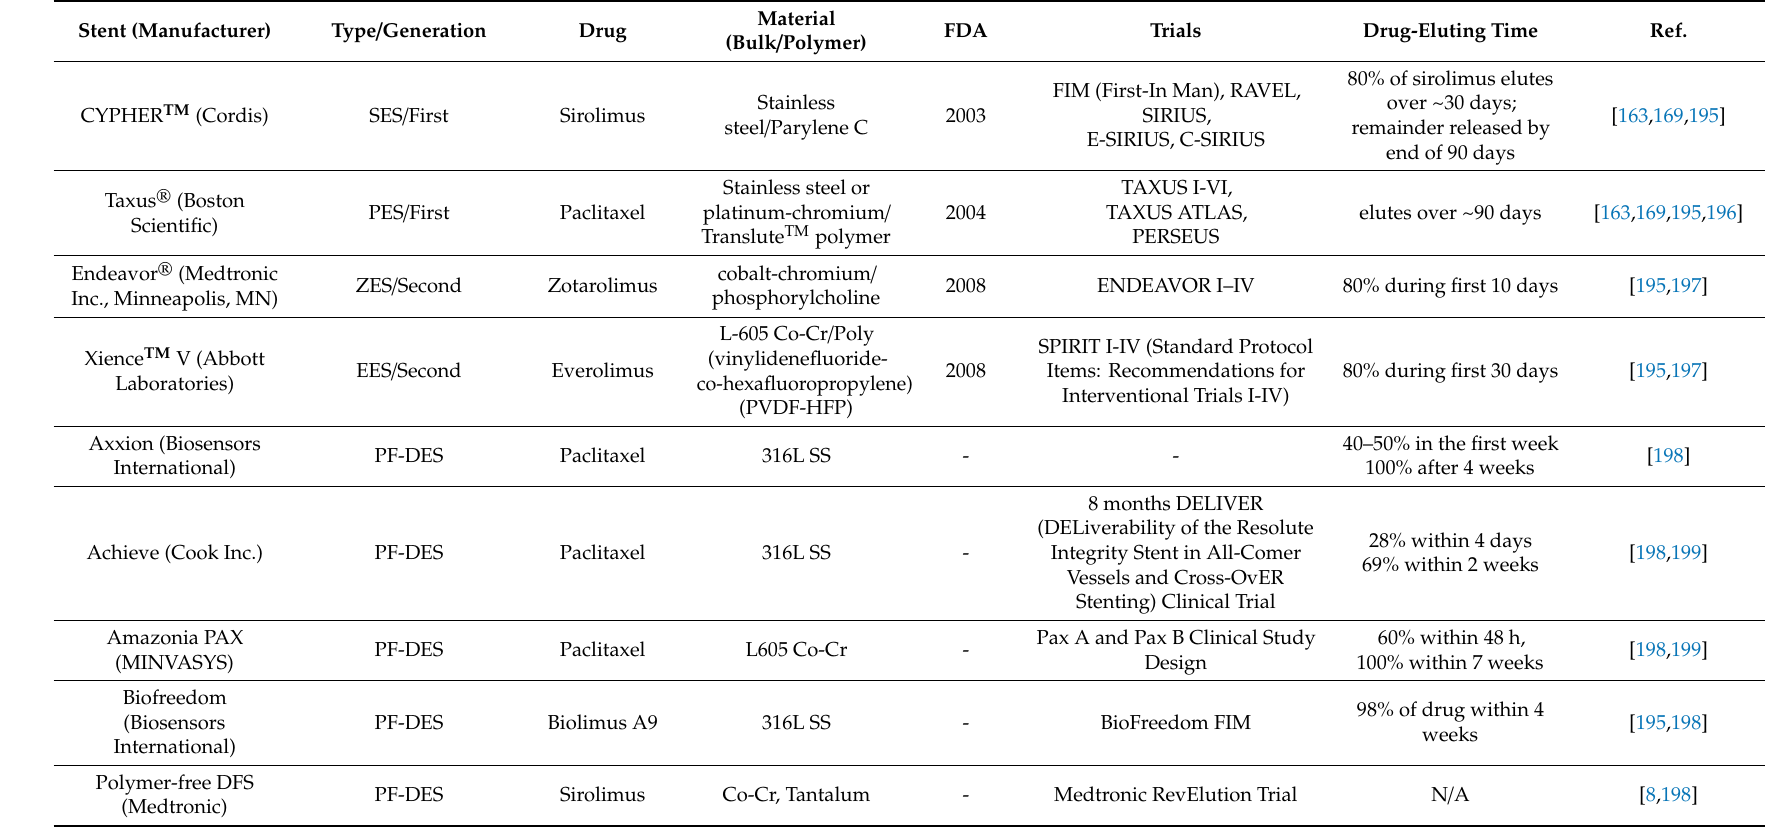
Table 3. Overview of drug-eluting